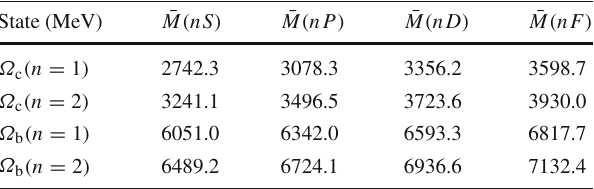
Fig. 1 Regge trajectories of the Ω c baryons relating the shifted spin- averaged mass squared to the orbital angular momentum L of the sys- tems, with the parameters m d = ss = 991 MeV and the Regge slope a = 0 . 316 GeV 2 corresponding to our assignment (13). The (red) solid circles correspond to the observed (mean) masses Table 4 Mean masses of the excited Ω Q ’s predicted by Eqs. (21) and